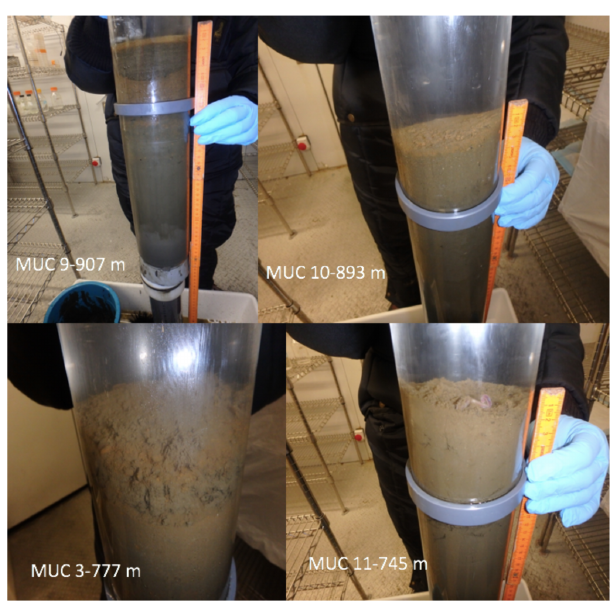
Figure 5. Photographs of selected 2016 MUC cores.